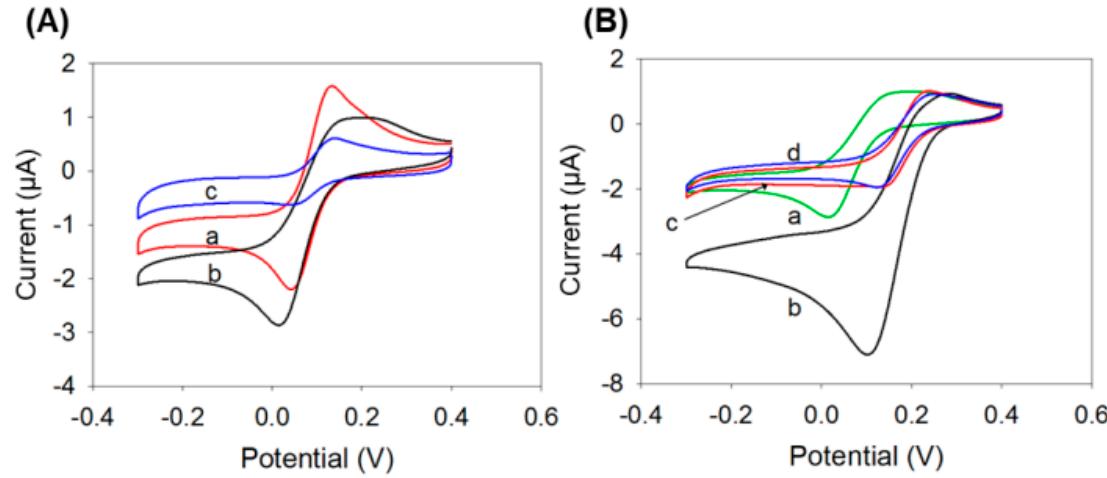
Figure 4. Cyclic voltammograms of the BCNPs/Tyr/Nafion/GCE biosensor in response to 100 µ M BPA, ( A ) depending on various amounts of BCNP loading (a-c represent 0.25, 0.375 and 0.5 mg mL − 1 of BCNP concentrations, respectively), and ( B ) depending on various amounts of Tyr loading (a–d represent 0.1, 0.5, 1.0 and 1.5 mg mL − 1 of Tyr concentrations, respectively). Scan rate: 0.05 V s − 1 .